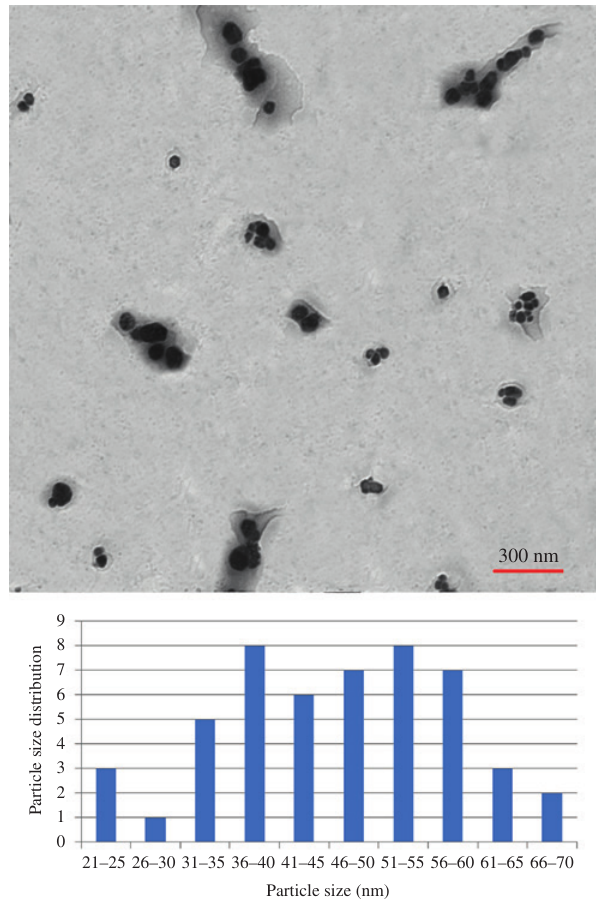
Figure 1: Transmission electron microscopy (TEM) micrographs of the green synthesized iron nanoparticles (INPs) (A) which indicate that nanoparticles are surrounded by a biologic matrix from leaf extract, and particle size distribution diagram of the INPs (B).